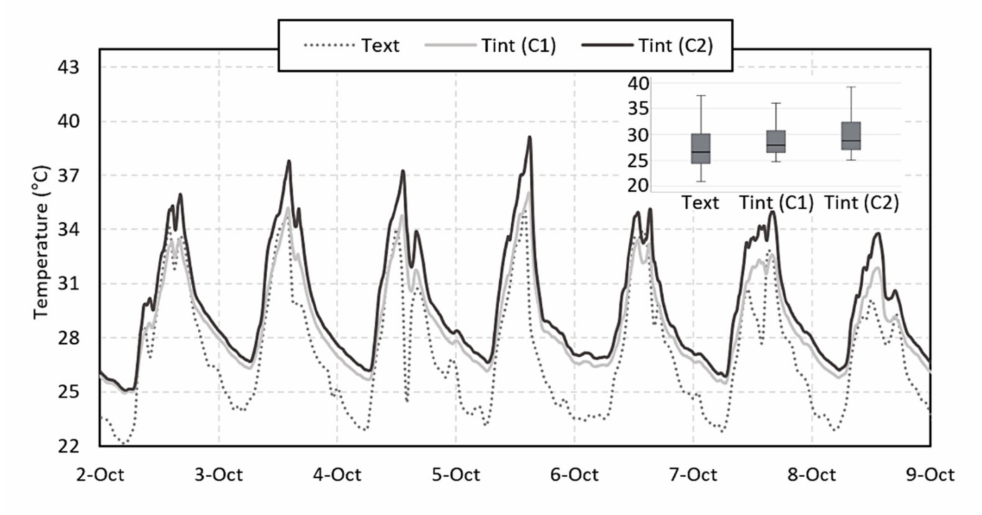
Figure 14. Variation of external and internal temperature in cells C1 and C2 during one week of campaign 4 (painting the opaque envelope with reflective paint).